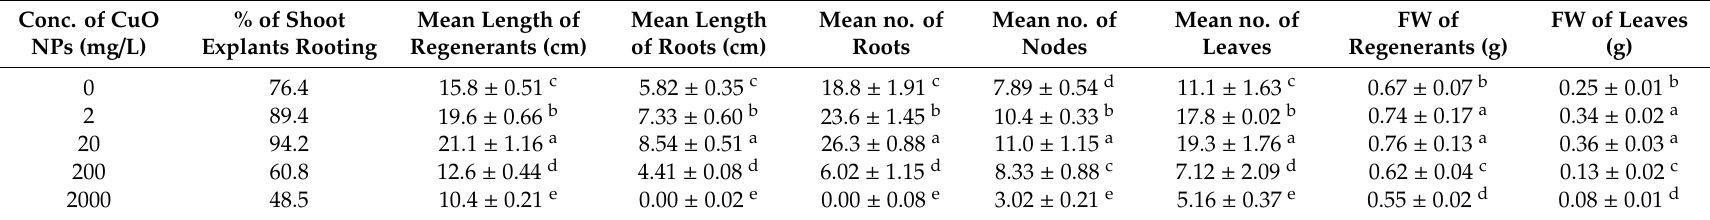
Table 3. Comparison of morphological parameters in 8 weeks old regenerants produced from shoots on MS medium supplemented with di ff erent concentrations of CuO ENPs. Conc. of CuO % of Shoot Mean Length of NPs (mg / L) Explants Rooting Regenerants (cm)